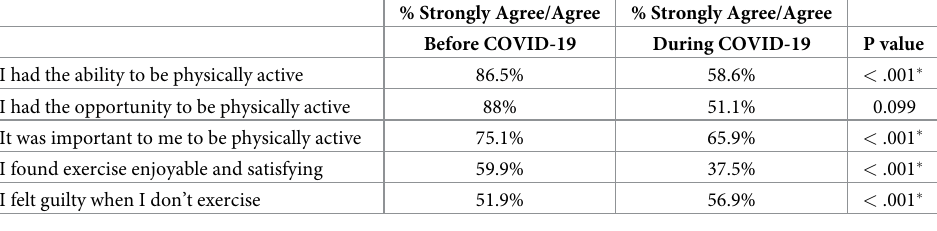
Table 4. Agreement with COM-B statements before and during COVID-19.